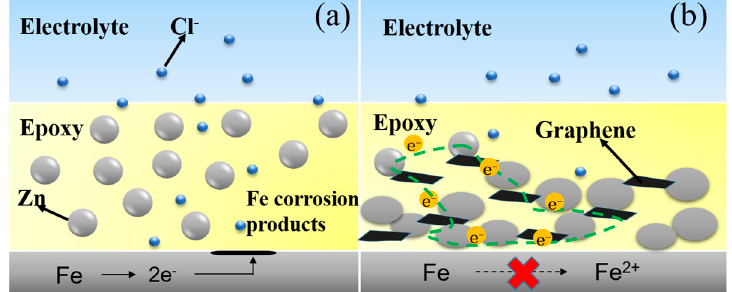
Figure 7. The schematic representation of ( a ) ZRPs and ( b ) Gr0.6-ZRPs during immersion in the electrolyte.